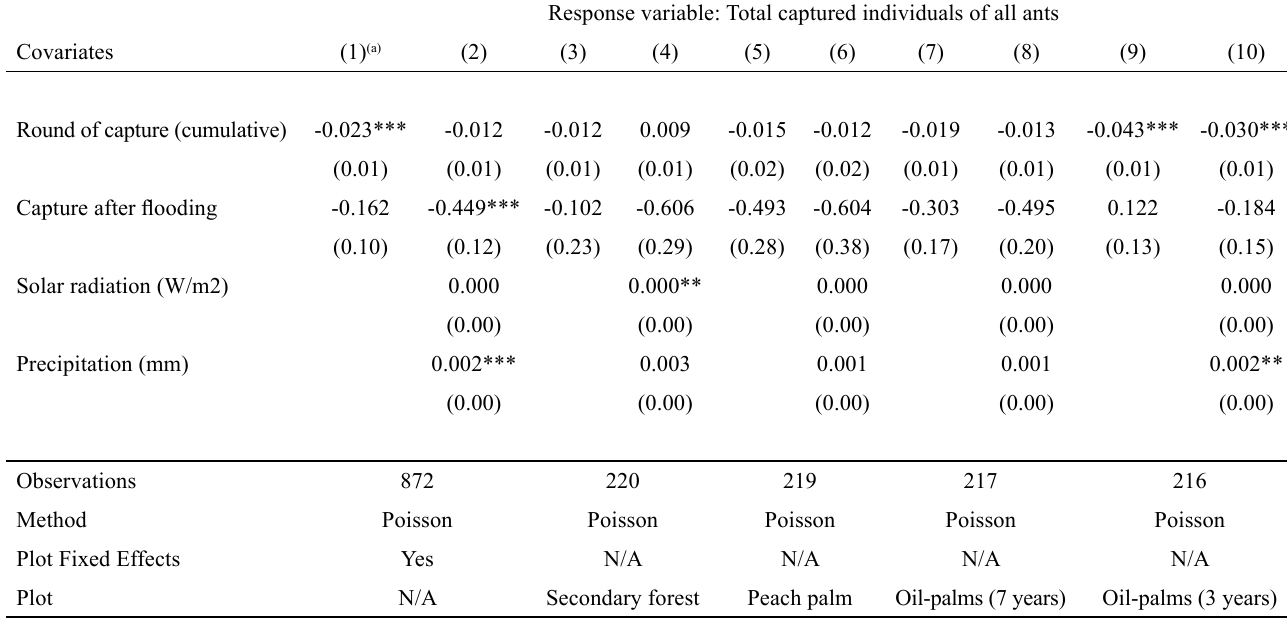
Table 3 . Estimated effect of pitfall trapping over all ants by Poisson regression